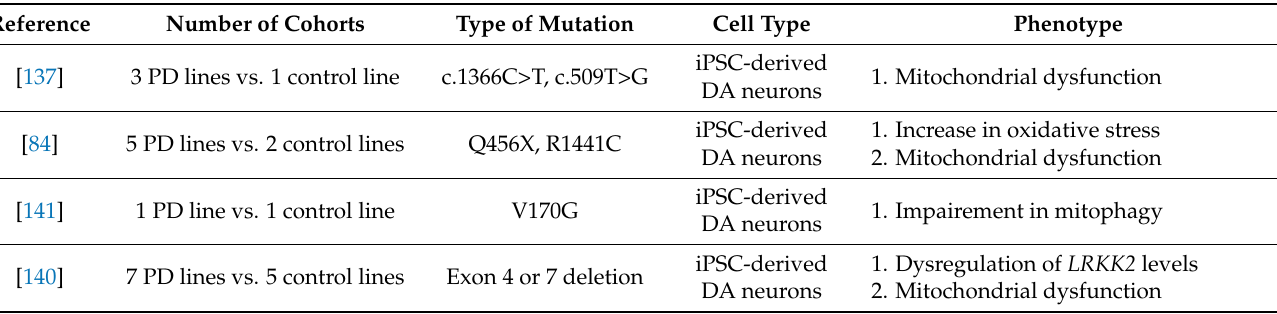
Table 4. PINK1-mutated iPSC-derived neuronal